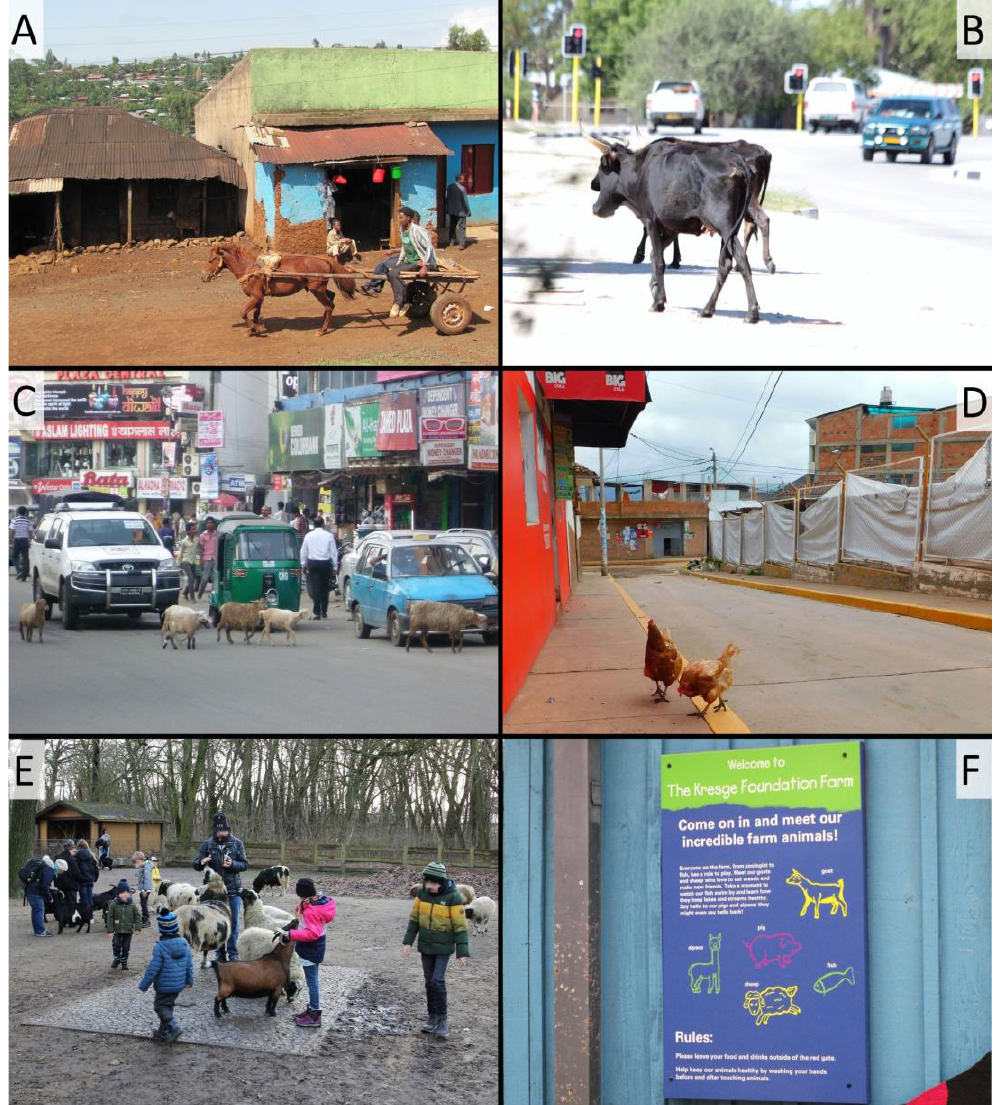
Figure 4. Livestock species found in urban areas in the Global South ( A – D ) and in the Global North ( E , F ). ( A ): horse pulling a wagon in Oromia region, Ethiopia; ( B ): cattle in Oshakati, Namibia; ( C ): sheep on the streets of Dhaka, Bangladesh; ( D ): chickens roaming in Cusco, Peru; ( E ): children’s zoo at Tierpark Berlin-Friedrichsfelde, Germany; ( F ): sign at children‘s zoo at Dallas Zoo, USA; photos: ( A , E ): G. Perry; ( B , E ): T. Göttert; ( C ): C. Hobelsberger; ( D ): J.S.